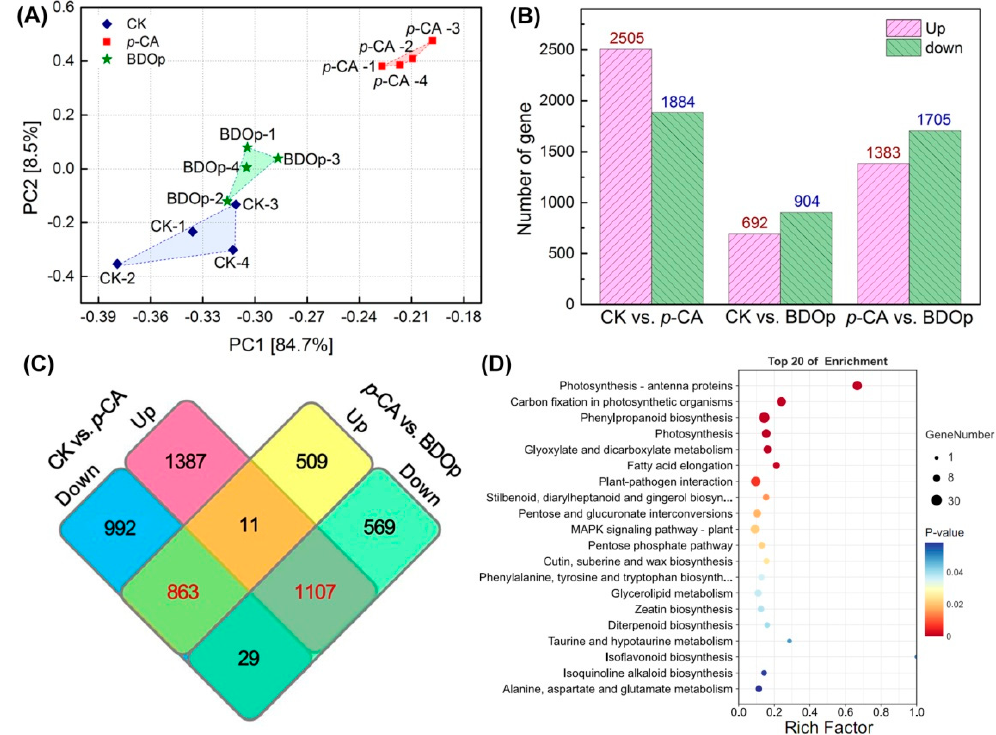
Figure 5. Principal component analysis (PCA) ( A ) of FPKM profiles in three treatment groups; The statistics of the up- and down-regulated DEGs in pairwise comparison of treatments ( B ). Venn diagram of the number of up-regulated and down-regulated DEGs in CK vs. p -CA and p -CA vs. BDOp pairwise comparison ( C ). The bubble diagrams for the top 20 KEGG pathways for 1107 up-regulated differentially expressed genes (DEGs) in CK vs. p -CA group ( D ). (CK: ddH 2 O control group; p -CA: treatment group with 10 mL 400 mg/L p -coumaric acid; BDOp: p -coumaric acid with biochar-dual oxidant particles. Each treatment was subjected to four biological replicates).